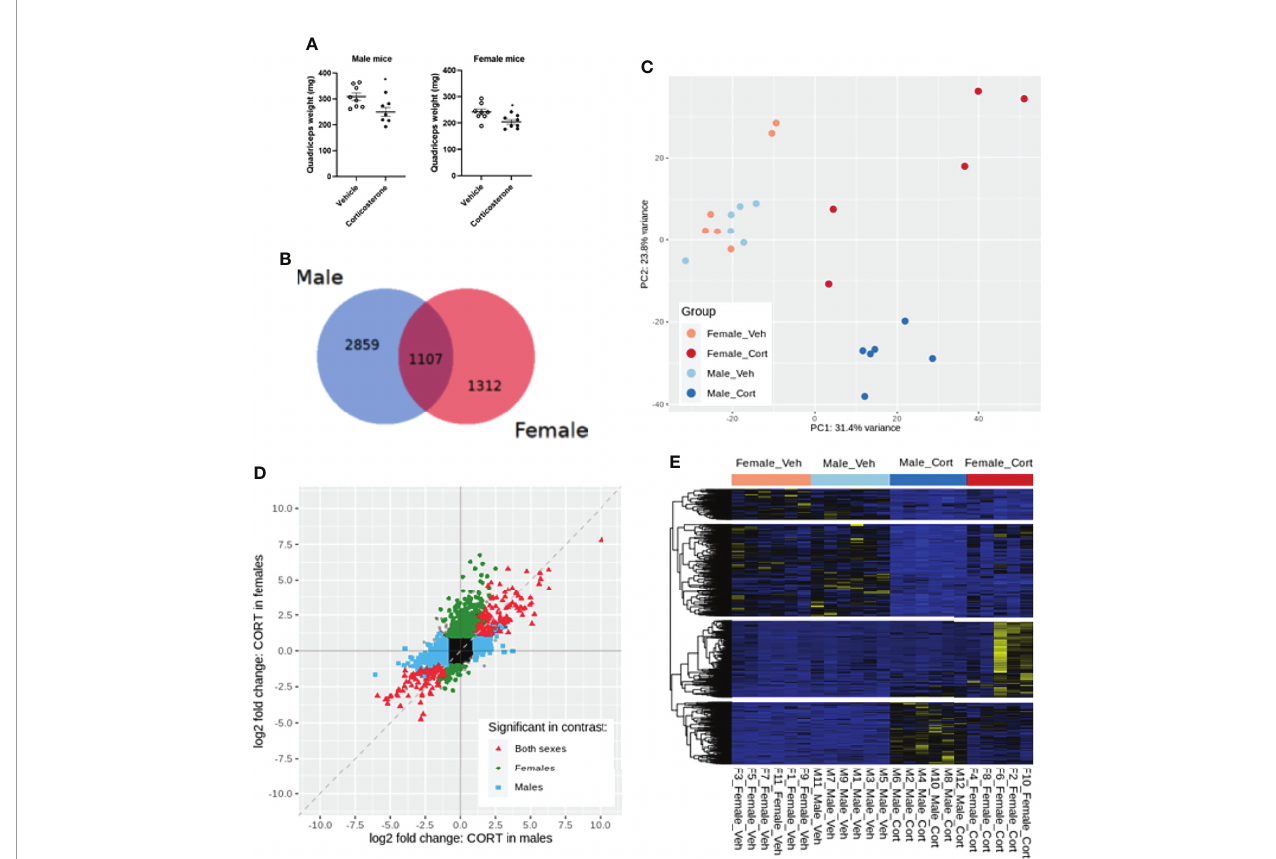
FIGURE 3 | Transcriptome pro fi ling of the quadriceps in male and female mice after corticosterone treatment. (A) The effect of corticosterone treatment on muscle weight of the quadriceps. (B) Venn-diagram representing sex-speci fi c and shared differentially expressed genes upon corticosterone treatment. (C) Principal component analysis of vehicle- and corticosterone-treated male and female C57BL/6J mice. (D) Fold change-fold change plot comparing signi fi cant changes in corticosterone-treated male and female mice. Male-speci fi c differentially expressed genes are shown in blue, female-speci fi c genes in green, and genes differentially expressed in both sexes in red. (E) Heatmap showing all genes regulated by corticosterone. A blue color code represents low expression, a yellow color code high expression. N=6 mice/group for all groups except female-Cort